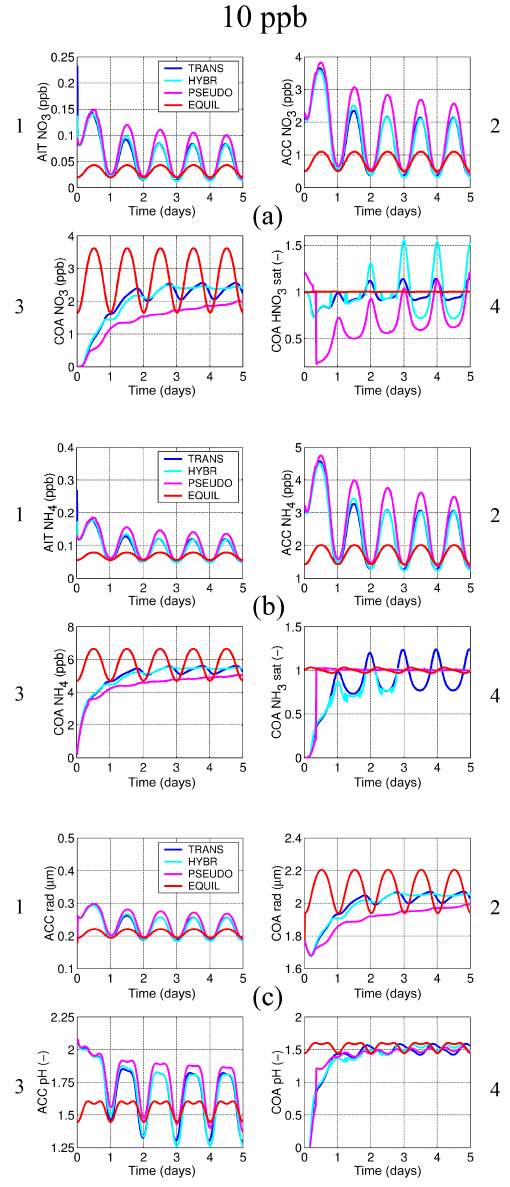
Figure 7. Same as Fig. 4 with initial mixing ratios of HNO 3 (g) and NH 3 (g) of